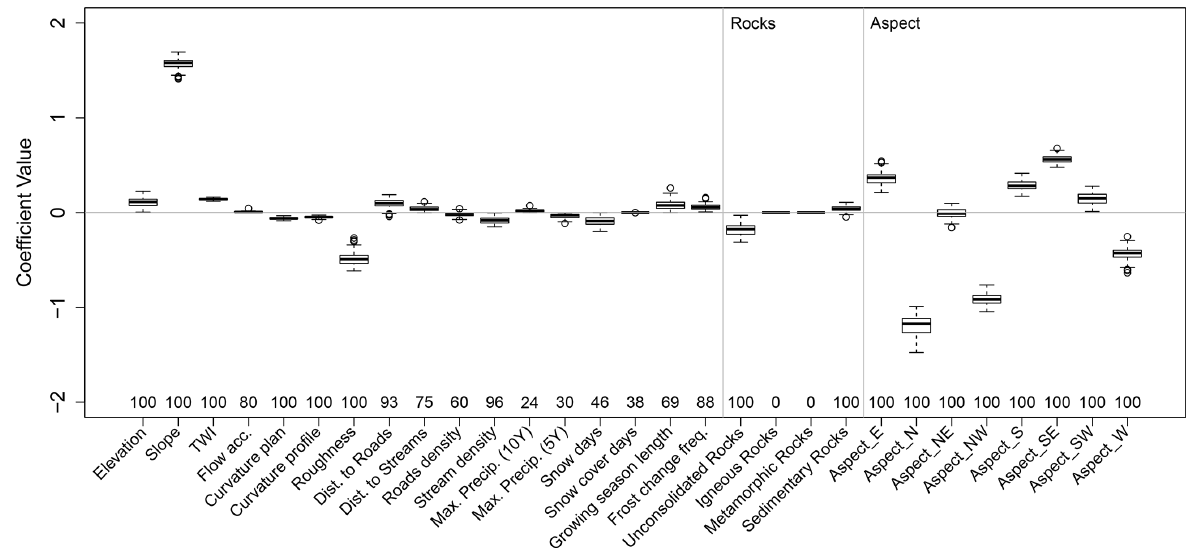
Figure 11. Boxplots showing the coefficient range with 100 repetitions. Numbers above variable names indicate the number of times it was selected for the